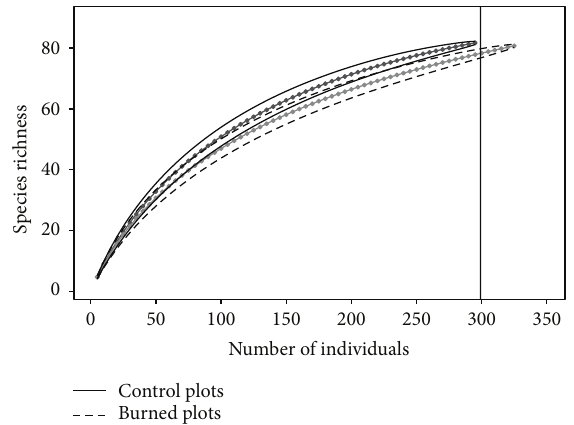
Figure 2: Species rarefaction curves for the control and burned plots surveyed in the present study in eastern Acre, Brazil. The lines represent the 95% confidence limits.